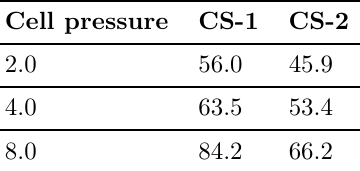
Table 2. Peak axial stresses in triaxial tests [MPa].